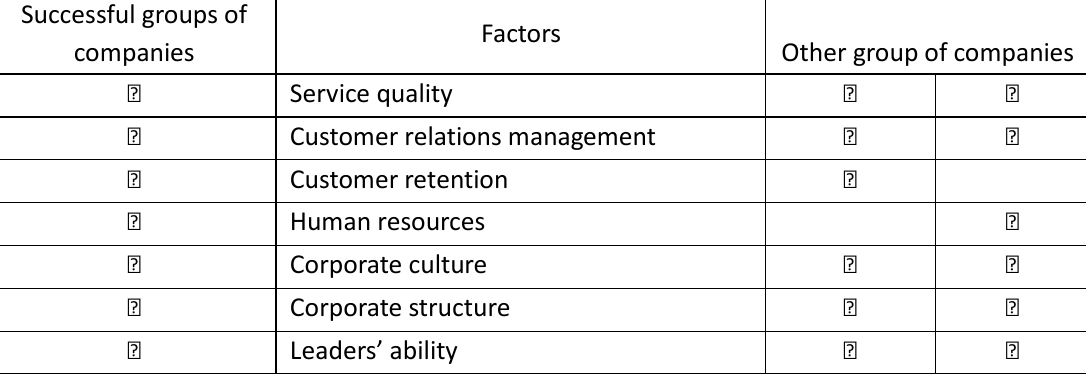
Table 3: A combination of factors that affect success of two business groups Successful groups of